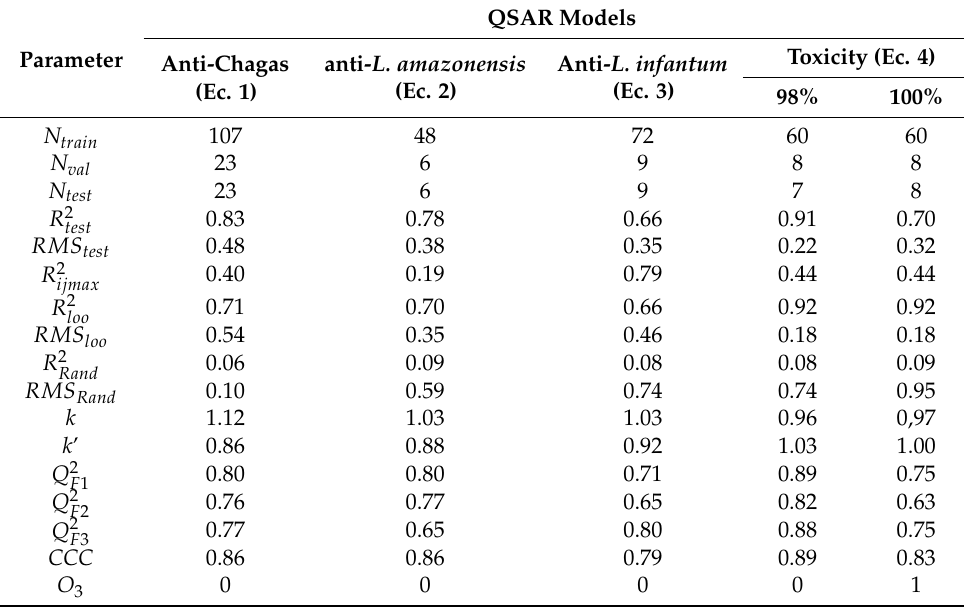
Table 5. Internal and external validation parameters for each best QSAR